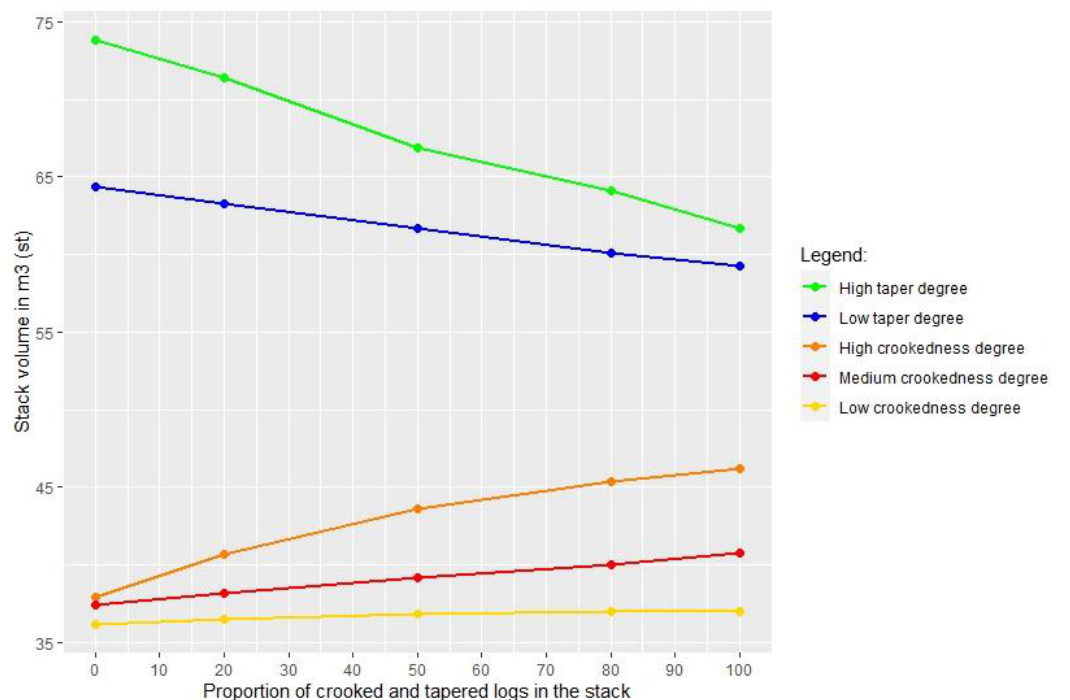
Figure 3. Stack volume variation according to increasing proportion of crooked and tapered wood.